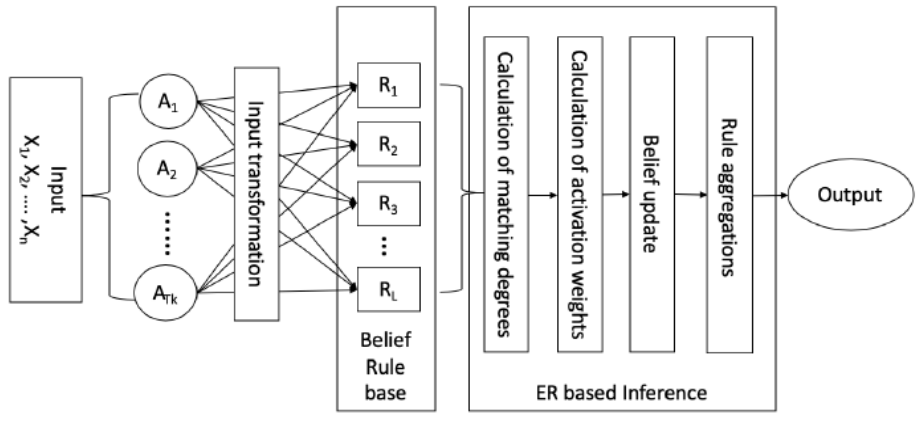
Figure 1. Working process of